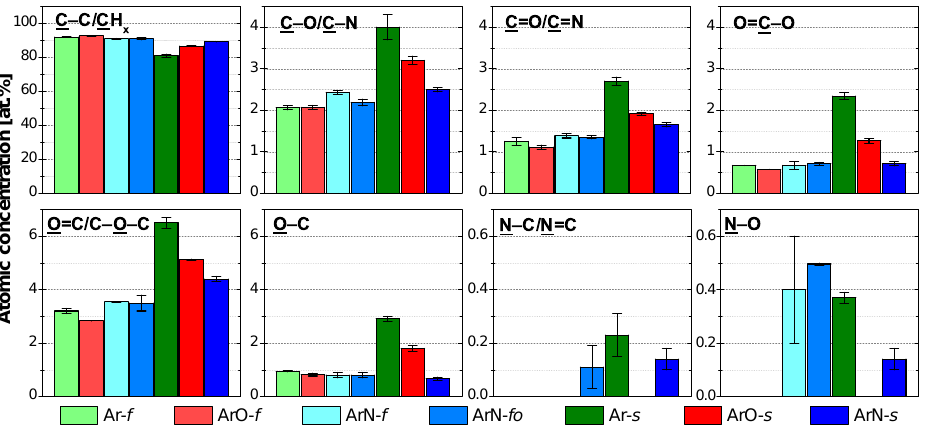
Figure 9. XPS C1s, O1s, and N1s high-resolution spectrum components and their atomic con- centrations for the water-washed plasma-treated PP samples. Spectra were measured right after